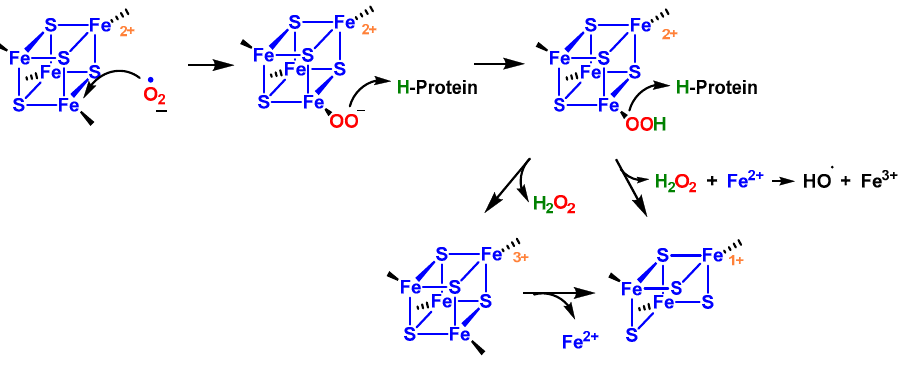
Figure 45. Reaction of the [4Fe-4S] cluster with O 2 •− . Loss of iron labile from the Fe-S centre